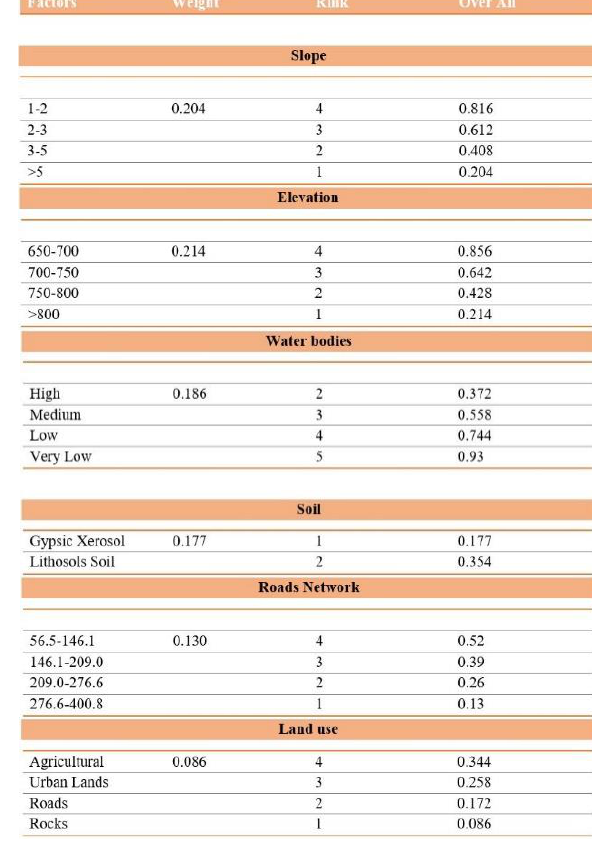
Table 4 : The rating of the six criteria selected based on literature review and weights.